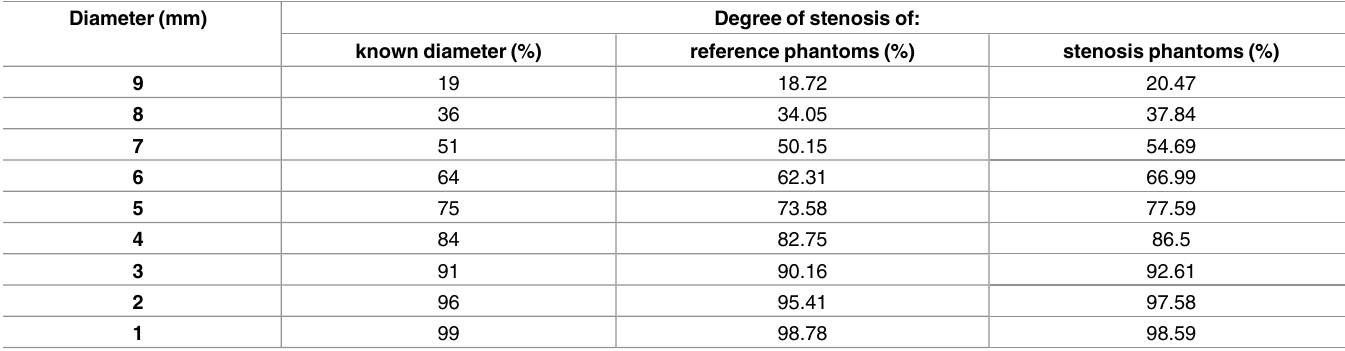
Comparison of the stenosis values calculated based on the known diameters of each stenosis phantom (2 nd column), calculated by division of the average intensity of each reference phantom by the MPI signal intensity of the 10 mm reference phantom (3 rd column) and calculated by the ratio of average intensities between stenotic and non-stenotic section of each stenosis phantom (4 th column). Resovist dilution was 1:100. mm = millimeter, % =